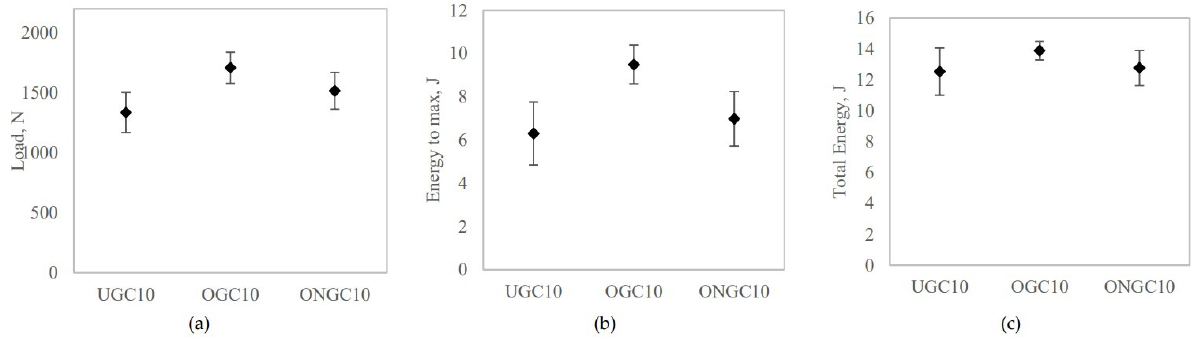
Figure 6. Load-Energy-Time graph of impact test for UGC, OGC and ONGC.